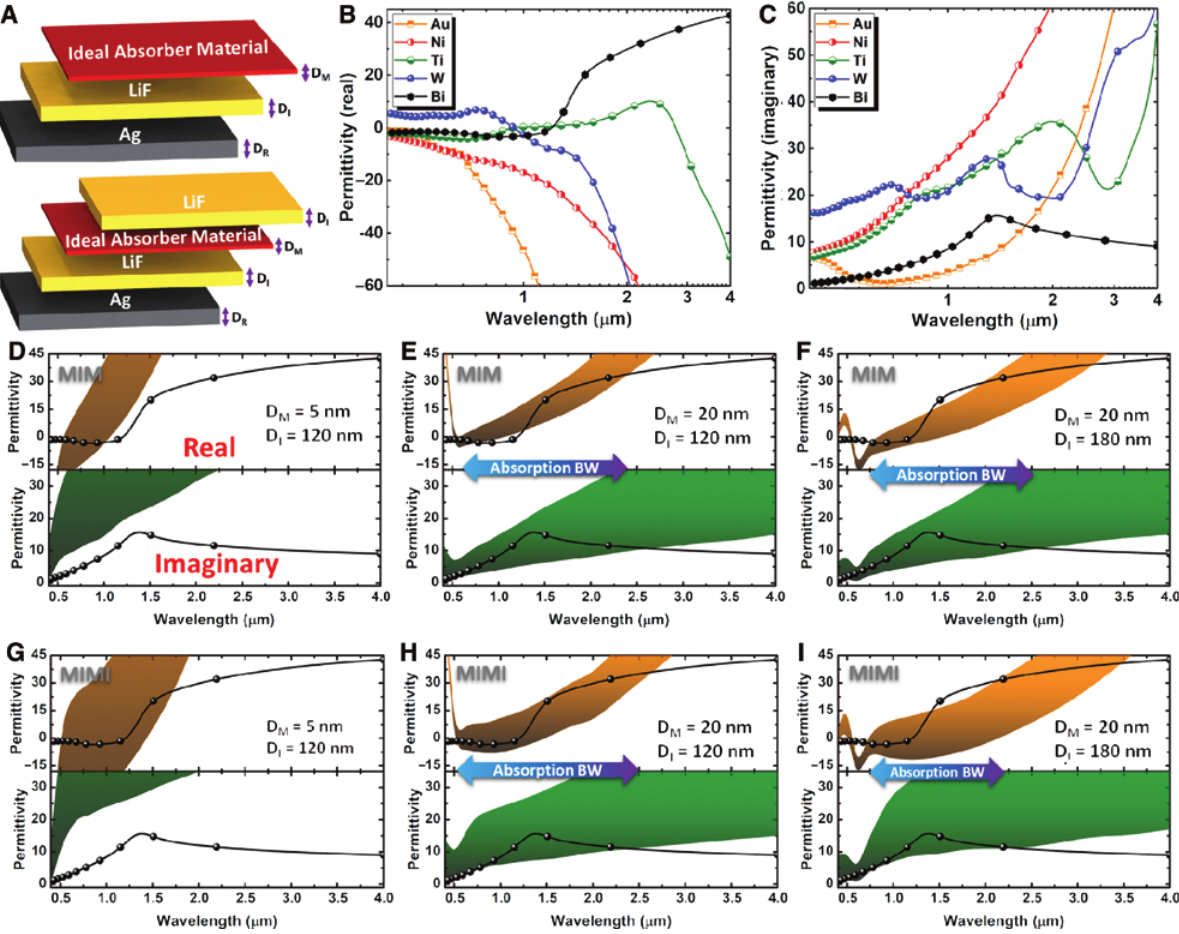
Figure 1: The matching condition between Bismuth and ideal absorber. (A) The schematic representation of metal-insulator-metal (MIM) and metal-insulator-metal-insulator (MIMI) cavity designs. The (B) real and (C) imaginary parts of permittivity for different types of metals, including Bi. The extracted ideal absorption regions for the real and imaginary = 5 nm and D = 120 nm, (E) D = 20 nm and D = 120 nm, parts of permittivity in an MIM cavity design for three different configurations of (D) D M I M I = 20 nm and D = 180 nm. The extracted ideal absorption regions for the real and imaginary parts of permittivity in an MIMI cavity and (F) D M I = 5 nm and D = 120 nm, (H) D = 20 nm and D = 120 nm, and (I) D = 20 nm and D = 180 design for three different configurations of (G) D M I M I M I